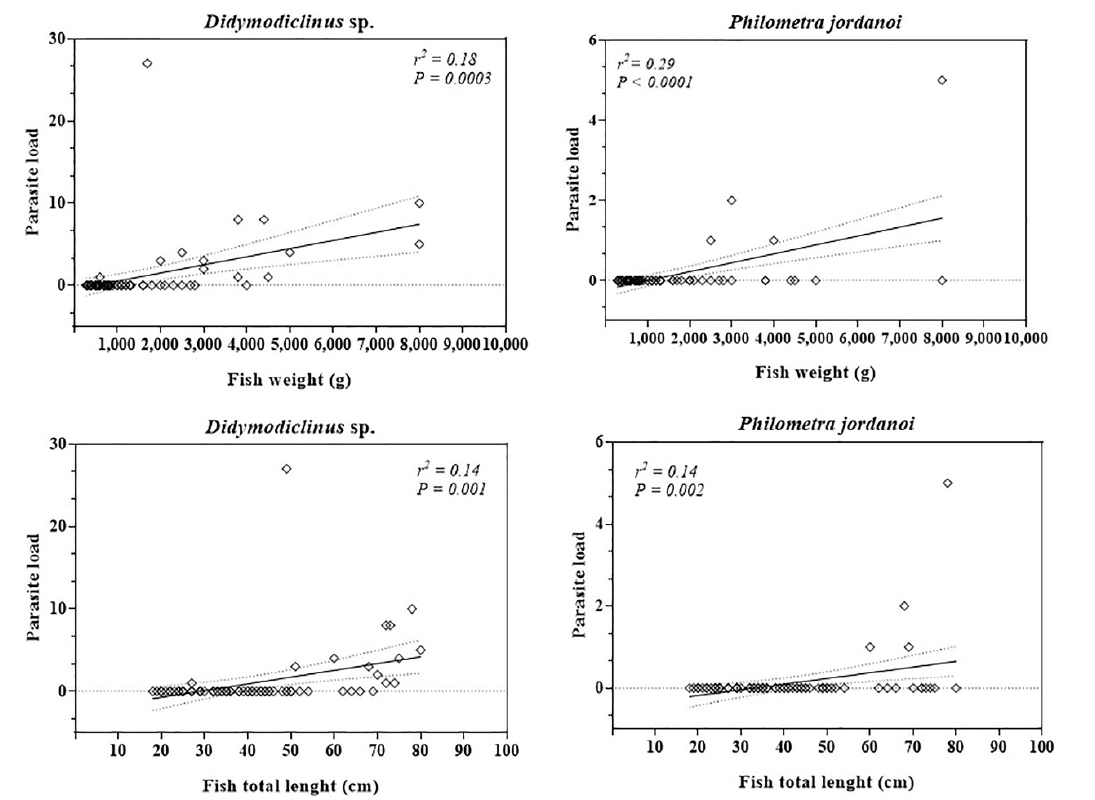
Figure 5. Linear regression values obtained between biometric data (weight and length) of Epinephelus marginatus and prevalence of infection of Didymodiclinus sp. and Philometra jordanoi .